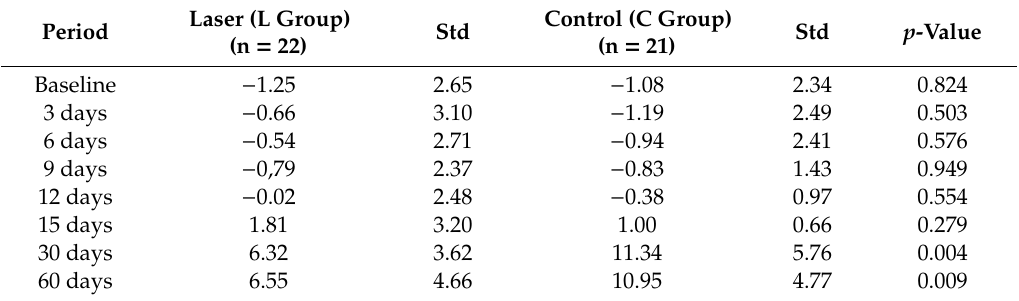
Table 1. Irradiation results recorded in the form of Periotest values (PTVs) at various time points in both the L and C